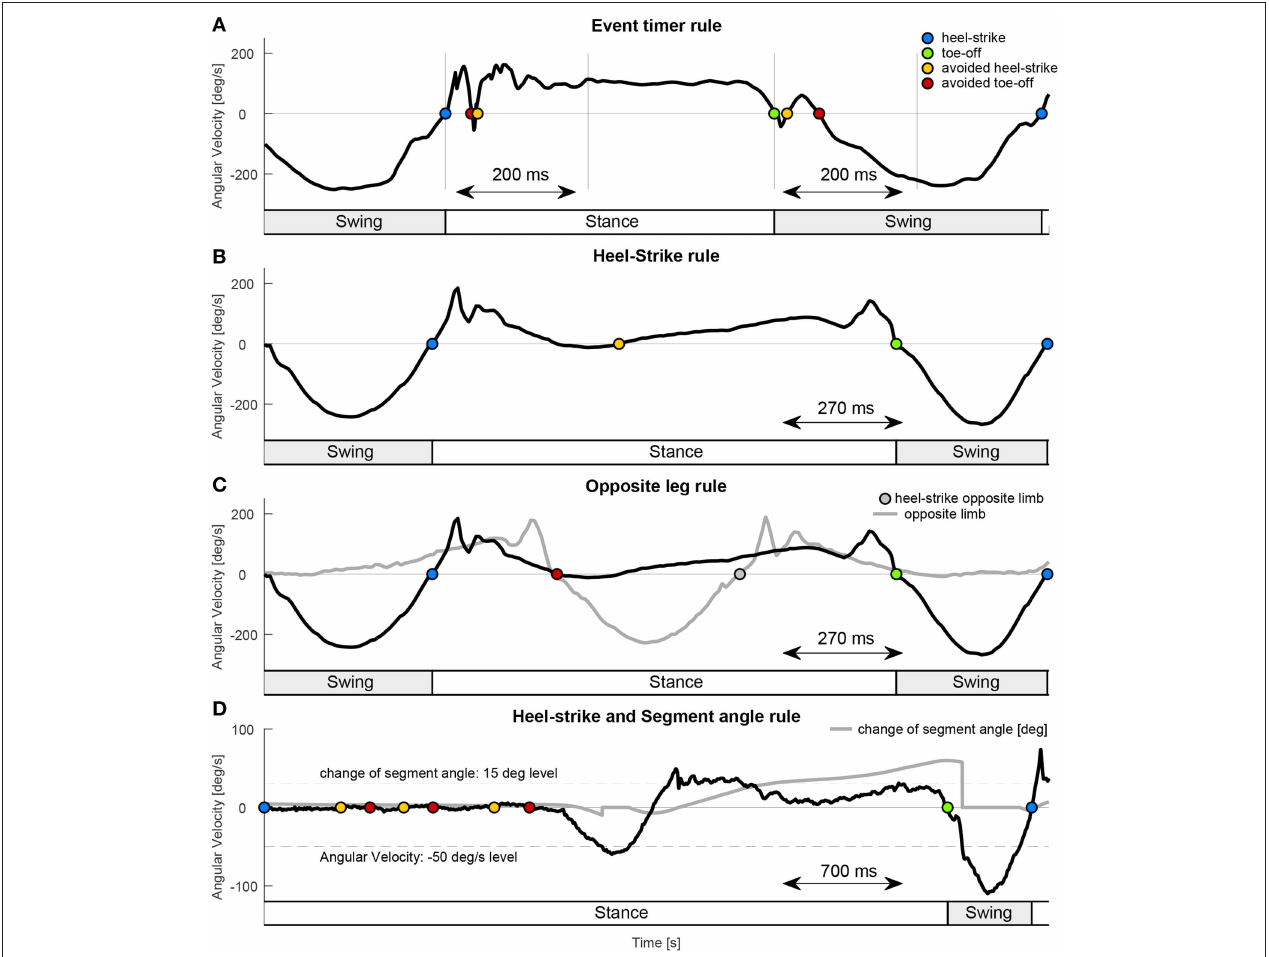
FIGURE 4 | Examples for the applied rule sets. (A) The Event timer rule used a defined time interval after each event detection (heel-strike blue, toe-off green) to avoid additional hell-strike (yellow) or toe-off (red) detections. The example used an interval of 200ms for the virtual leg during walking declines (1.7m/s). (B) The Heel-strike rule ensured that after heel-strike only toe-off and after toe-off only heel-strike can be detected. In this example the Opposite leg rule is required in addition to also avoid the toe-off detection. (C) The Opposite leg rule required the heel-strike of the opposite limb (gray solid) before a toe-off can be detected. The example data for (B,C) is from the shank segment during walking inclines (0.9m/s). (D) The Segment angle rule (was not applied for the analysis) required a change of 15 ◦ in the segment angle (set to zero when angular velocity larger than − 50 ◦ /s) to allow toe-off (green) detection. In combination with the Heel-strike rule it can avoid toe-off detection while standing. The example data is from the shank segment during gait initiation of walking inclines. Heel-strike is set as initial condition. The timing of the stance and the swing, indicated by the bottom bars for (A–D) is based on the rule